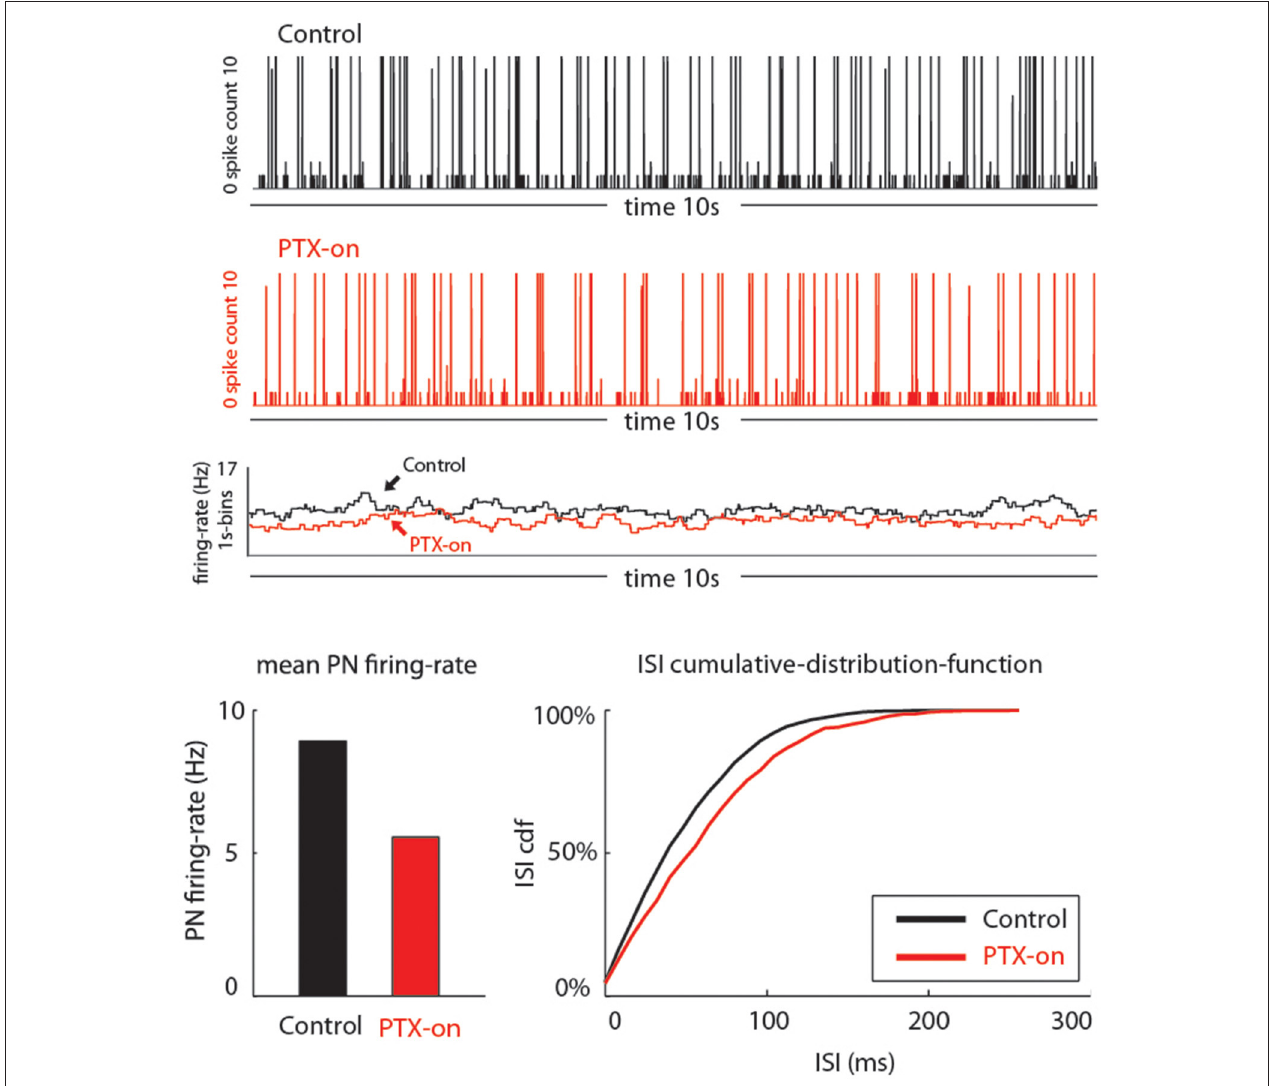
FIGURE 5 | Our model qualitatively reproduces the PTX-induced phenomena seen in Figure 4. On top we show traces of PN-activity for a model glomerulus in background, both in the control state (black) and PTX-on state (red). Below these traces we plot the time-averaged PN firing-rate (averaged over 1s bins). On the bottom we show the average PN firing rates (left) and cumulative-distribution-function for the ISI-intervals (right).